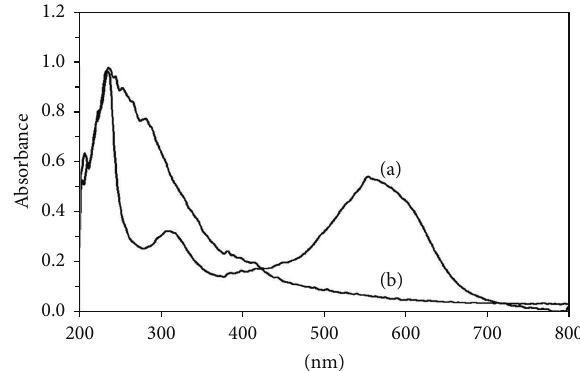
Figure 9: UV-Vis spectra of Reactive Violet 5 before and after decolorization by Paracoccus sp. GSM2 (a, 0 hour; b, 16